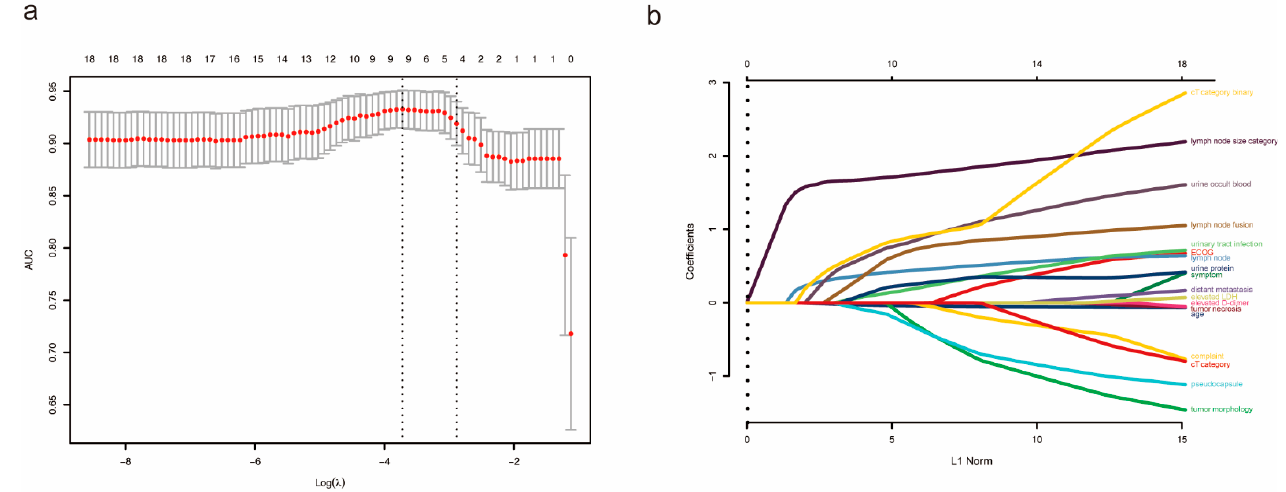
Figure 1. Result of lasso regression analysis. ( a ) Optimal predictor (lambda) selection in the lasso model. ( b ) lasso coefficient profiles of 18 predictors.